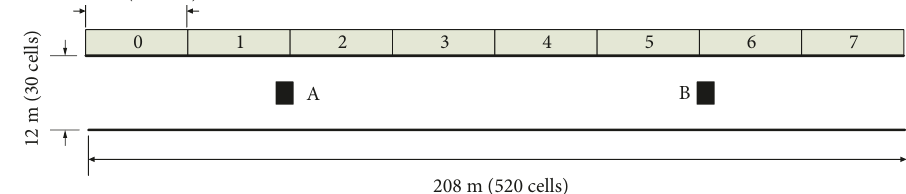
Figure 6: The simplified sketch of the HRS